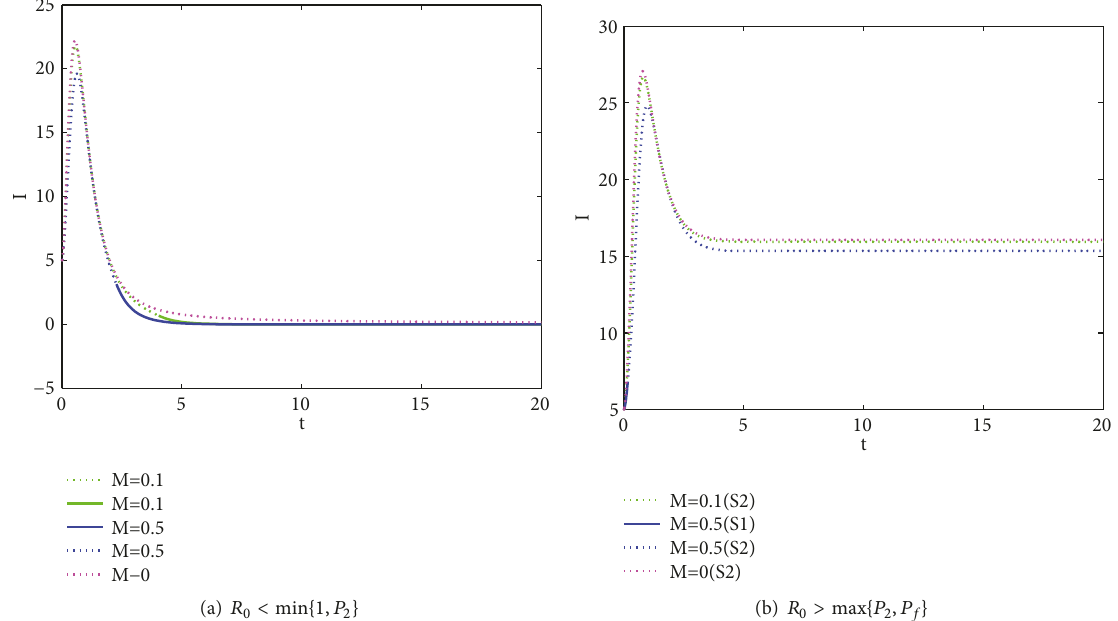
Figure 4: Time series of the infected dairy cows. The common values of (a) and (b) used for the parameters are as follows: 𝑤 = 3 , 𝑑 = 2 , 𝑐 = 0.8 , 𝛿 = 4 , 𝑞 = 1 , 𝛽 = 0.2 , 𝑎 = 2 , 𝑚 = 0.2 . The different values of (a) and (b) are (a) 𝐴 = 10 and (b) 𝐴 = 50 . The solid line or 𝑆1 means that 𝐼